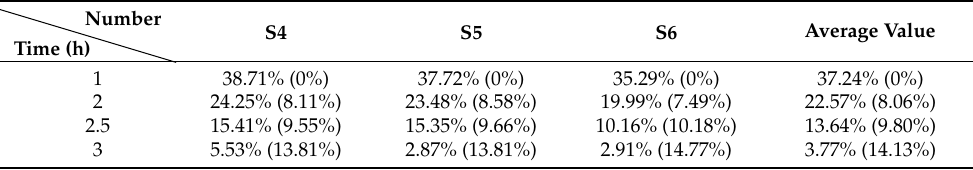
Table 3. The relationship between the time and fissure rate of S4–S6 of soil samples with particle size of 5